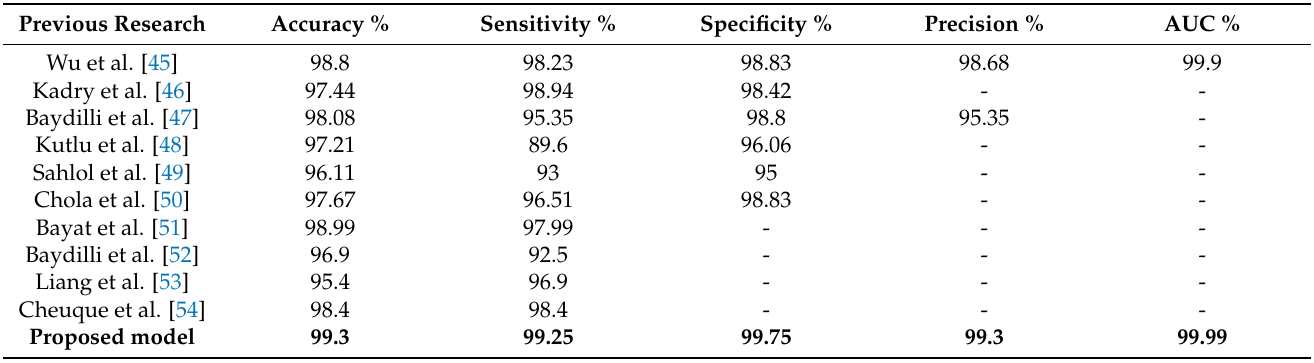
Table 7. Results from the implementation of the proposed methods compared to those of rele- vant